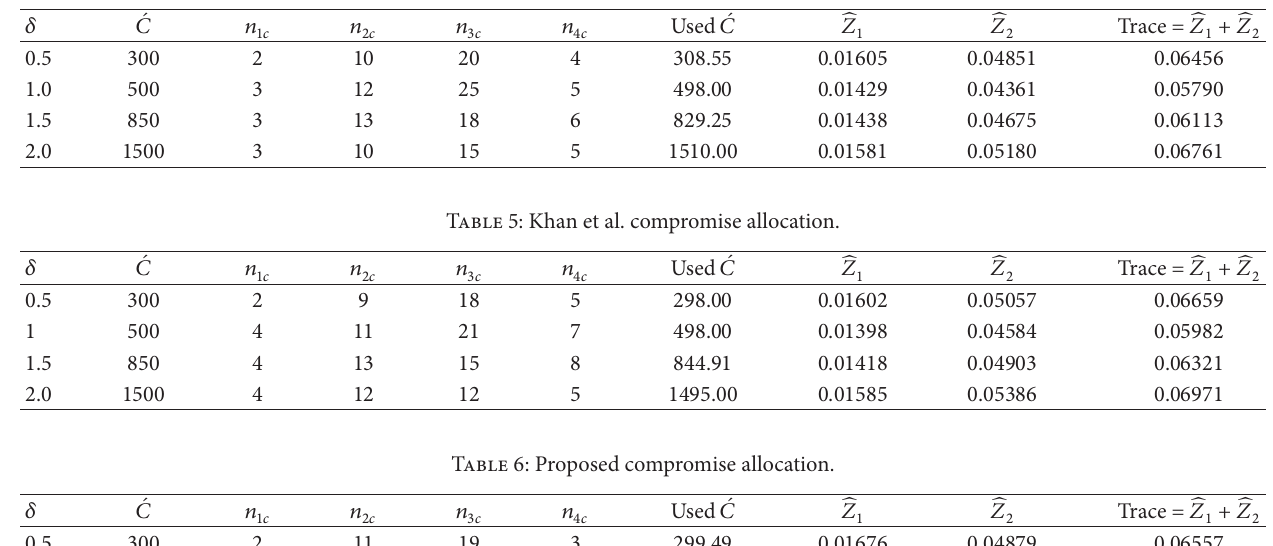
Table 4: Cochran’s compromise allocation.